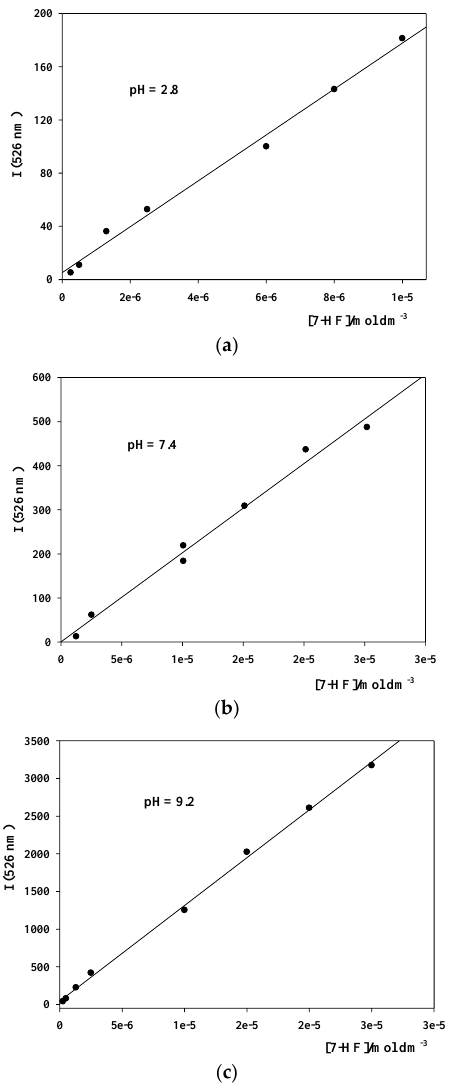
Figure 3. Fluorescence emission intensity calibration straight lines for 7-HF at different pHs. ( a ) pH = 2.0; ( b ) pH = 7.4; ( c ) pH = 9.2. T = 298.0 ± 0.1